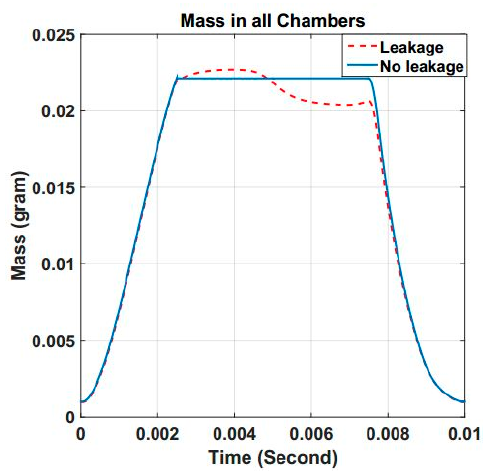
Figure 12. Mass of working fluid vs. time over one cycle (100 Hz).